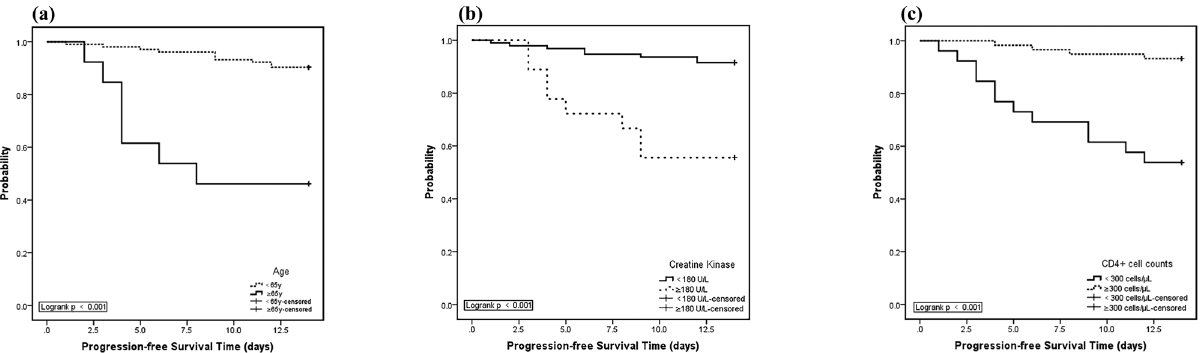
Figure 1: Kaplan – Meier curves for rates of not developing severe COVID - 19 during 14 days after hospital admission. ( a ) Kaplan – Meier curves showed worse progression - free survival rates for COVID - 19 patients aged 65 years or older compared to patients younger than 65 years ( p < 0.001, two sided ) ; ( b ) Kaplan – Meier curves showed worse progression - free survival rates for COVID - 19 patients with CK ≥ 180U/L compared to patients with CK < 180U/L ( p < 0.001, two sided ) ; ( c ) Kaplan – Meier curves showed worse progression - free survival rates for COVID - 19 patients with CD4 + T - cell counts < 300cells/µL compared to patients with CD4 + T - cell counts ≥ 300 cells/µL ( p < 0.001, two sided )